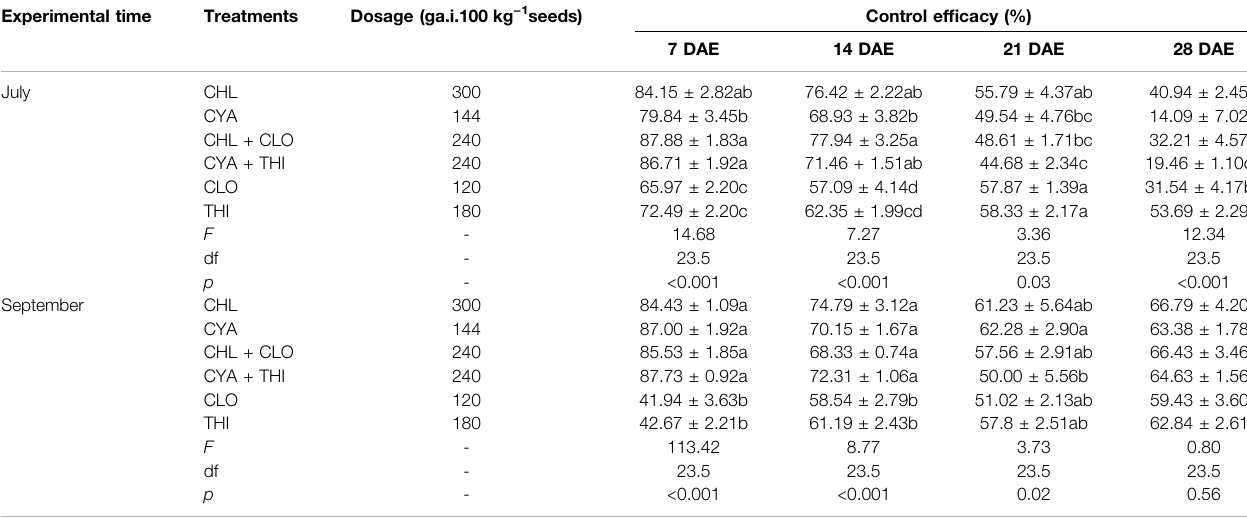
TABLE 2 | Control ef fi cacy (mean ± SE) of six insecticidal seed treatments for control of FAW on corn in the fi eld. Experimental time